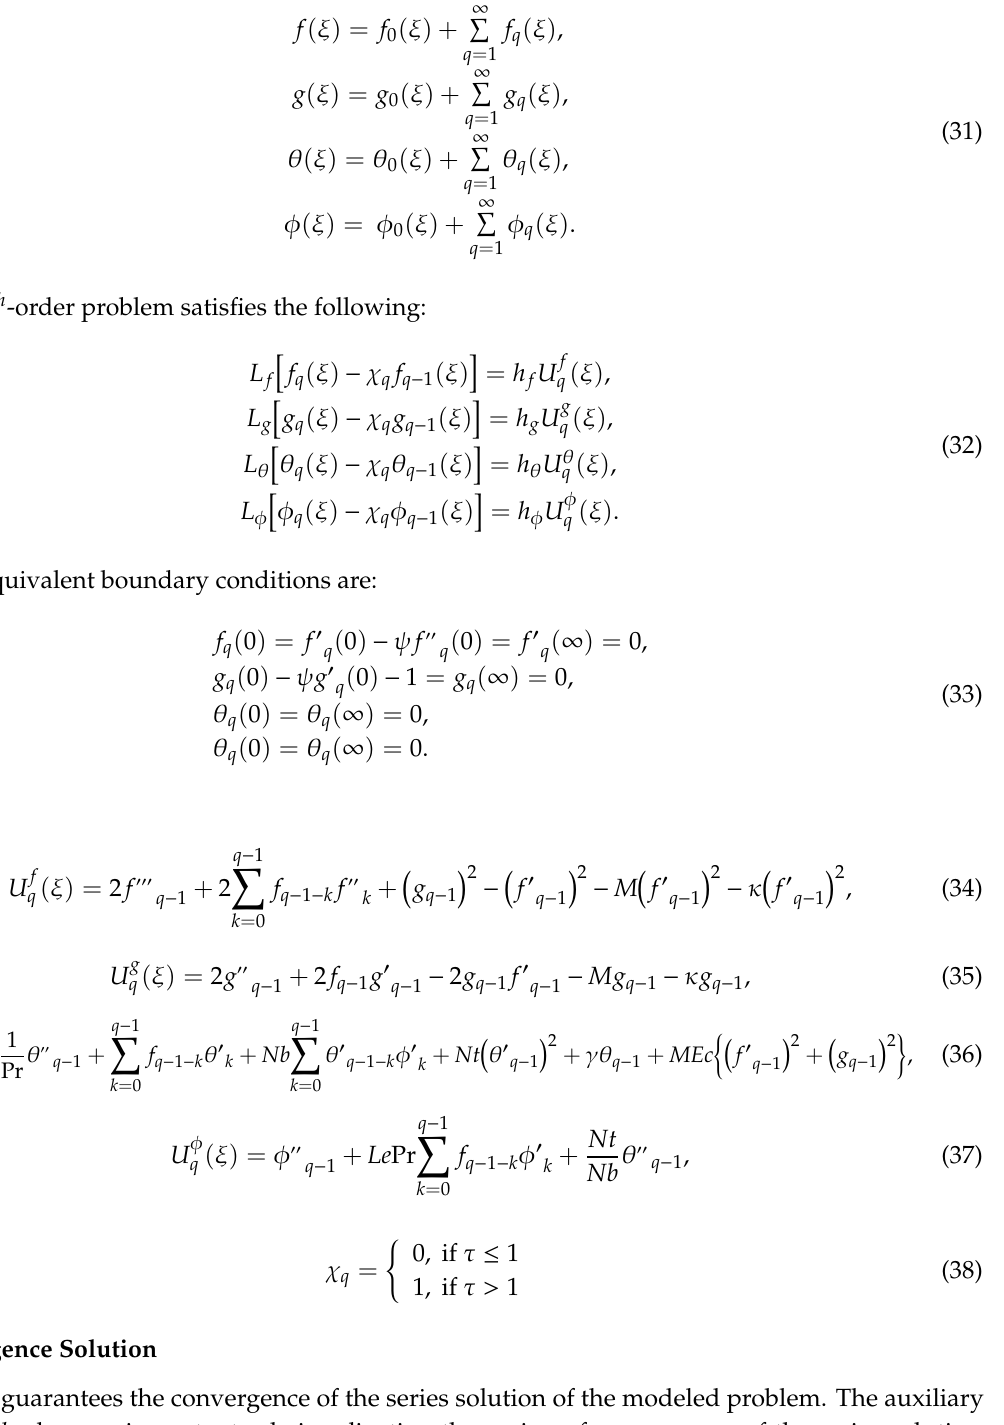
Figure 2 indicates the h − curves of the velocities profiles. The auxiliary parameters h f and h g are − 0.26 ≤ h ≤ 0.1 and − 0.22 ≤ h ≤ 0.06. Figure 3 indicates the h − curves of the temperature and g f concentration profiles. The auxiliary parameters h θ and h φ are − 0.28 ≤ h f ≤ 0.02 and − 0.24 ≤ h g ≤